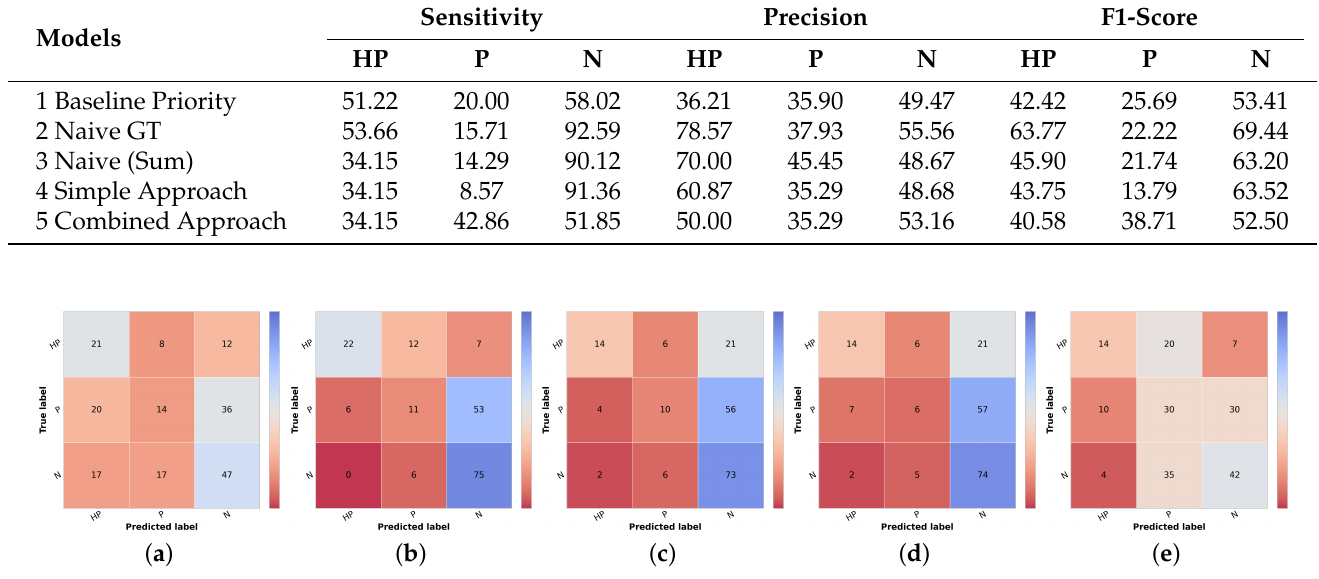
Table 14. Resulting metrics (%) of test set 2 of each final priority class for the different approaches.